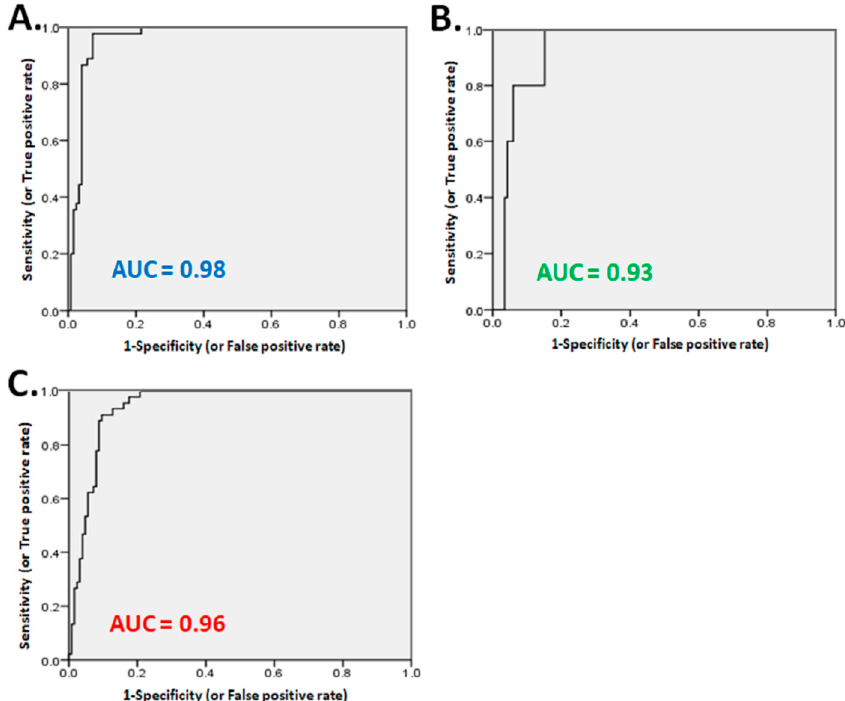
Figure 2. The evaluation of abnormal perfusion extent of LV myocardium in Dynamic SPECT/CT for predicting significant stenosis in patients. The area under the curve was 0.98(95% CI, 0.95–1.01), and if >5% of ischemic extent of LV that yielded significant stenosis ( A ), the sensitivity and specificity were 89.8% and 99.1%, respectively. The area under the curve was 0.93(95% CI, 0.83–1.02), and if >15.3% of moderate abnormal perfusion extent of LV that yielded significant stenosis ( B ), the sensitivity and specificity were 64.8% and 91%, respectively. The area under the curve was 0.96(95% CI, 0.90–1.01), and if >27.3% of combined ischemic and moderate abnormal perfusion extent of LV that yielded significant stenosis ( C ), the sensitivity and specificity were 77.8% and 97.3%, respectively. (AUC: area under curve).